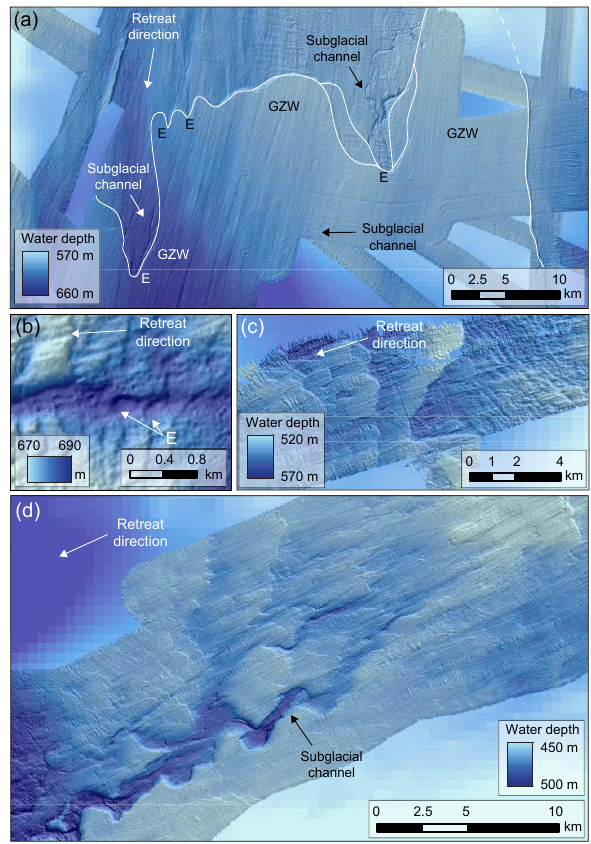
Figure 12. (a, b) Examples of the corresponding locations of sub- glacial channels and grounding zone wedge embayments, resulting in sinuous grounding line configurations. Additional examples of grounding zone wedge sinuosity (c) downstream of and (d) adja- cent to a large channel system. All mapped grounding line land- forms in (b–d) are grounding zone